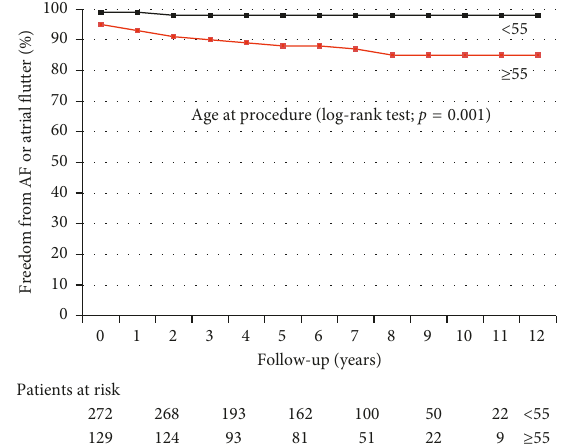
Figure 5: Kaplan–Meier plot showing freedom from AF over a 10- year time frame.